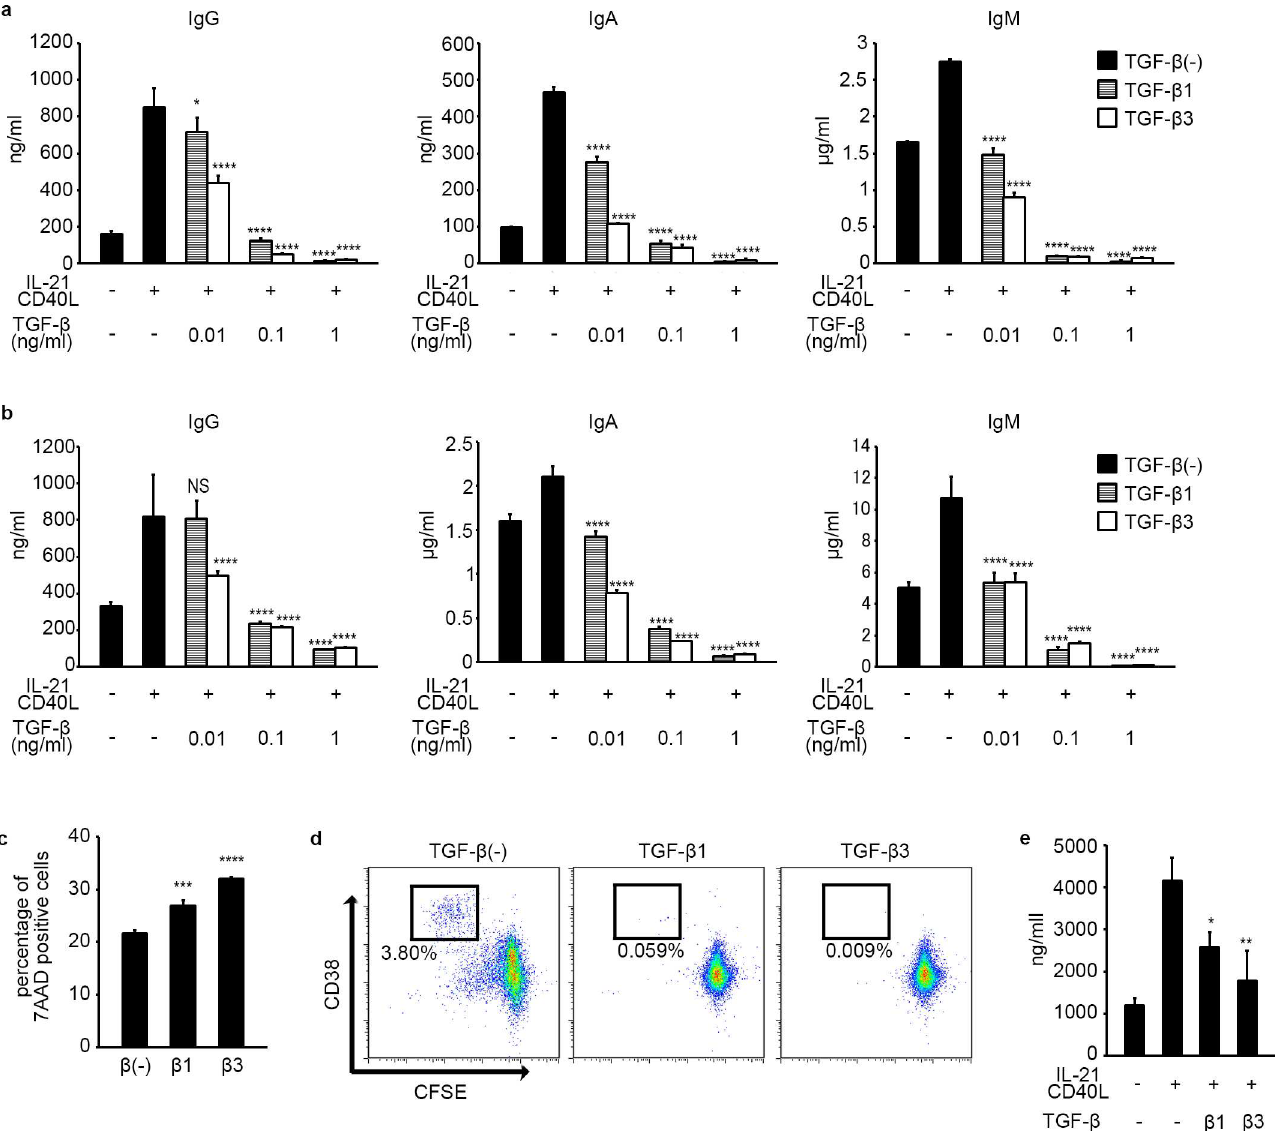
Fig 1. TGF- β 3 inhibits B cell antibody production. (a, b) B cells were culturedunder IL-21 and CD40L stimulationfor 11 days in serum containing medium (a) or serum free medium (b), and antibody production was assessedby ELISA. Among the IL-21 and CD40L stimulatedsamples, each of the TGF- β treated sampleswas compared with TGF- β untreated sample using one way ANOVA, Dunnett test (n = 3). Results are representative of two similar experiments. (c) B cells were culturedas in (a) and the percentage of 7AAD positive cells among CD19 + cells were assessed by flow cytometry. TGF- β treated samples were comparedwith TGF- β untreatedsample using one way ANOVA, Dunnett test (n = 3). Results are representative of two similar experiments. (d) B cells were cultured under IL-21 and CD40L stimulationfor 5 days and cell proliferation and the percentageof CD38 high plasmablasts amongCD19 + 7AAD - cells were assessedby flow cytometry. Results are representative of two similar experiments. (e) PBMCs were stimulatedwith IL-21 and sCD40L for 12 days, and IgG production was assessed by ELISA. Among the IL-21 and CD40L stimulatedsamples, each of the TGF- β treated samples was comparedwith TGF- β untreatedsample using one way ANOVA, Dunnett test (n = 3). Results are representative of three